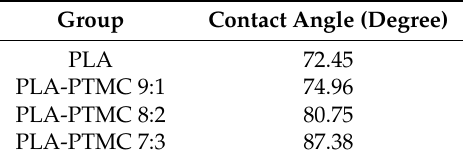
Table 2. Contact angle measurement.